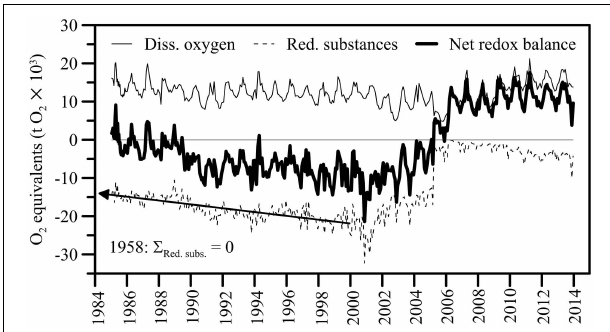
FIGURE 6 | Long-term evolution of redox balance in the northern basin of Lake Lugano (0–284m). O 2 equivalents of the sum of reduced solutes (i.e., NH + 4 , Mn 2 + , Fe 2 + , H 2 S and CH 4 ,) were calculated according to Van Cappellen and Wang (1996). Organic matter is not considered. The net redox balance represents the difference between the total amount of O 2 and the sum of reducing equivalents, expressed in metric tons (t) O 2 . The annual variation of the whole-lake O 2 and redox budgets follows the seasonal cycles of photosynthesis, respiration, and meromixis (i.e., lowered redox conditions during late summer and fall, high O 2 content after partial water-column overturn and the injection of O 2 -laden water into mid depths in winter). Prior to the early 2000s, reduced substances accumulated at a relatively constant rate of 510 t O 2 equivalents per year. Extrapolation of the long-term trend into the past indicates that the accumulation of reduced inorganic compounds in the water column started in 1958, marking the beginning of partial anoxia in the Lake Lugano North Basin.